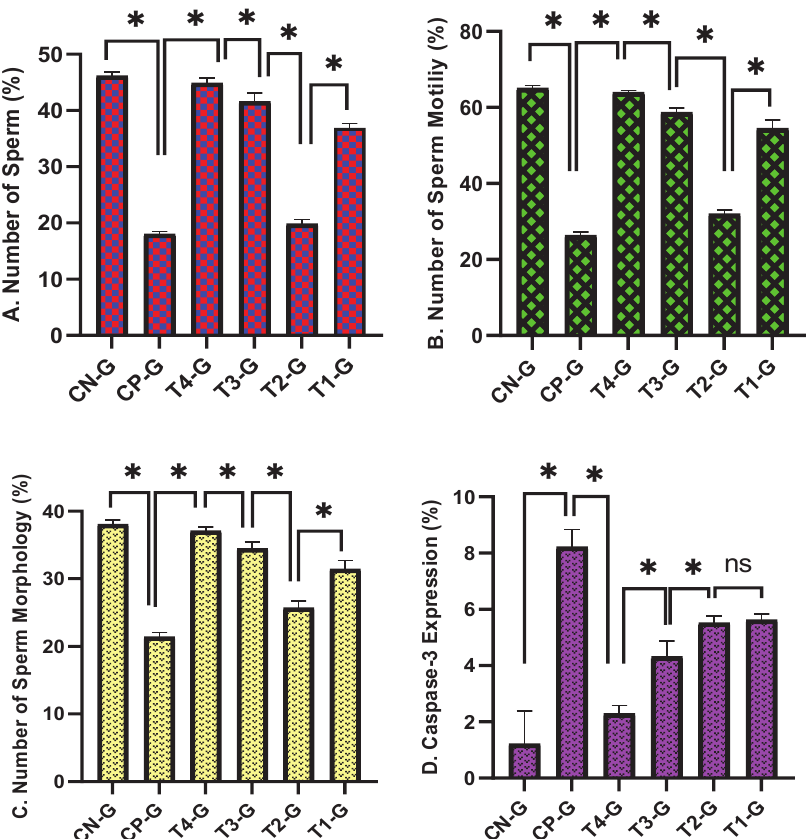
Figure 3. A. Number of sperm; B. Number of sperm motility; C. Number of sperm morphology; and D. Number of Caspase-3 Expression in each group. Post Hoc analysis: * p<0.05; ns: not significant